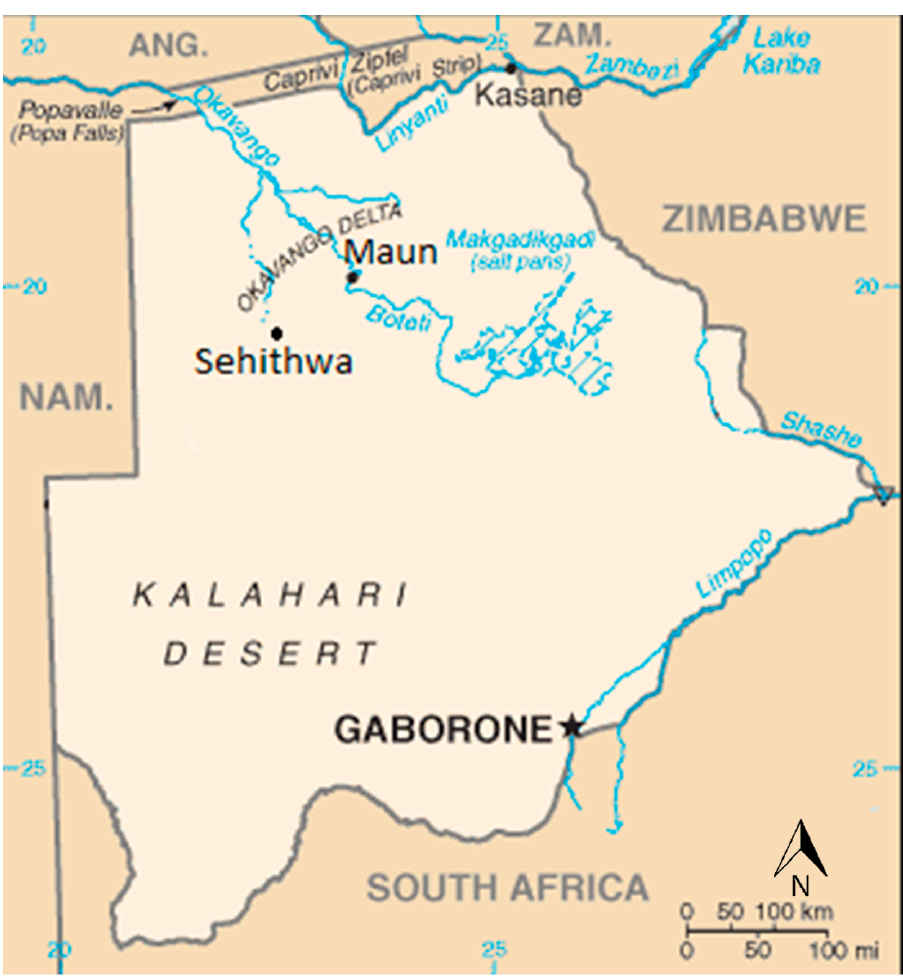
Figure 4. Map of Botswana showing areas where plants where collected (adapted from [74]).